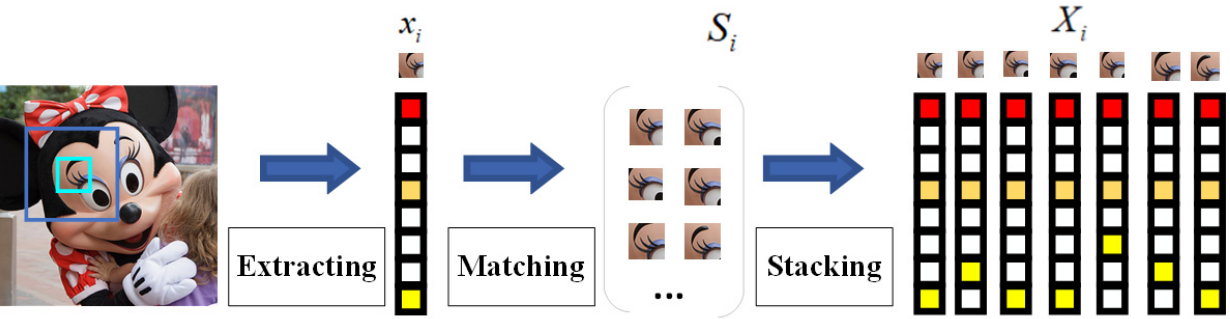
Figure 1. The construction diagram of the image group.